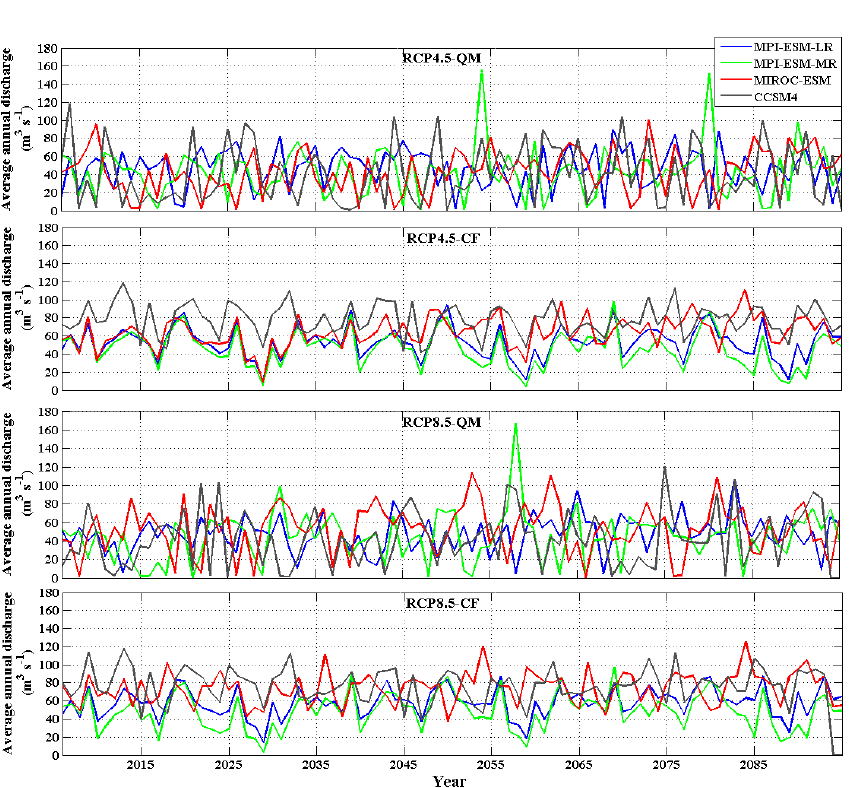
Figure 13. Possible changes in the average annual discharge cycle (on a monthly basis) at the upstream portion of the DRB for the four models when the two downscaling (QM and CF) methods were